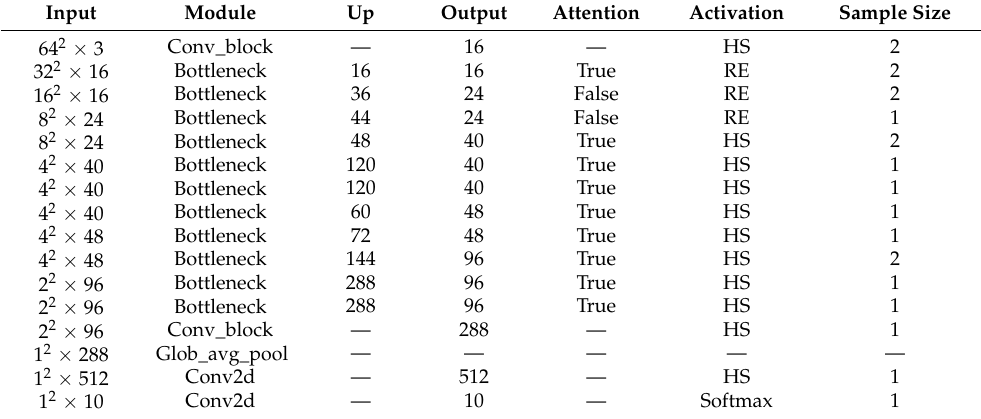
Table 2. Details of